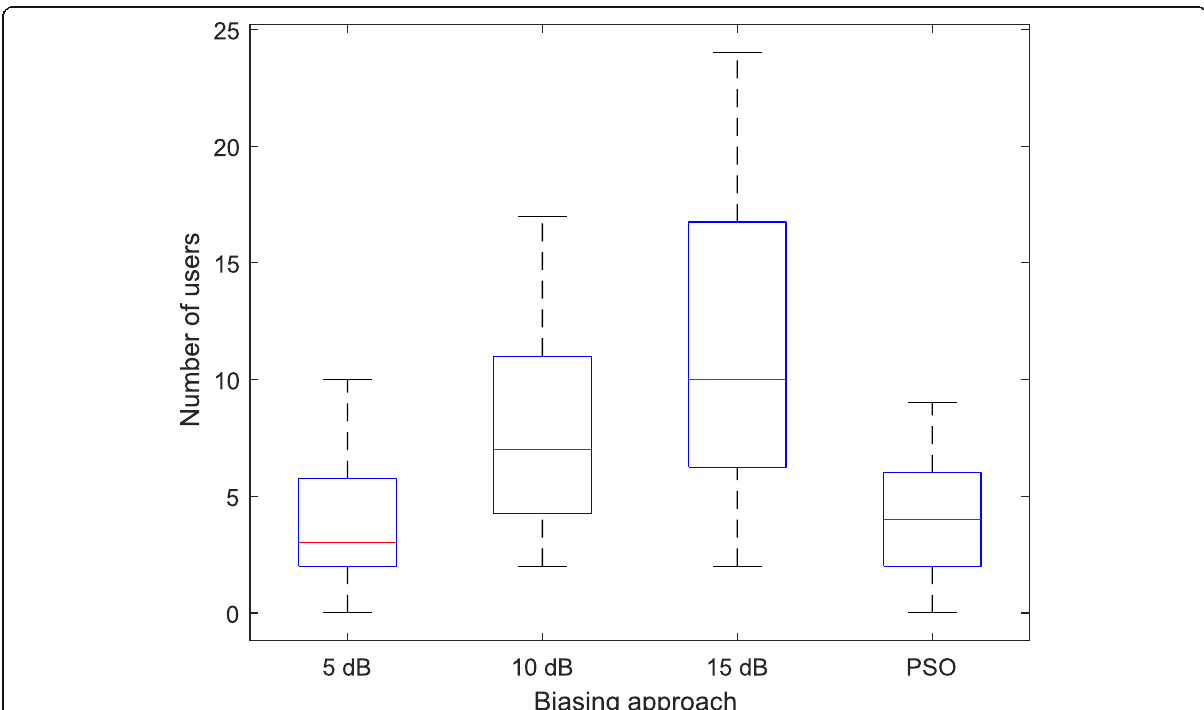
Fig. 5 Number of users associated to each BS for per-tier (0 – 15 dB) and per-BS (PSO) biasing approaches. This figure shows the load per base station when different biasing approached are